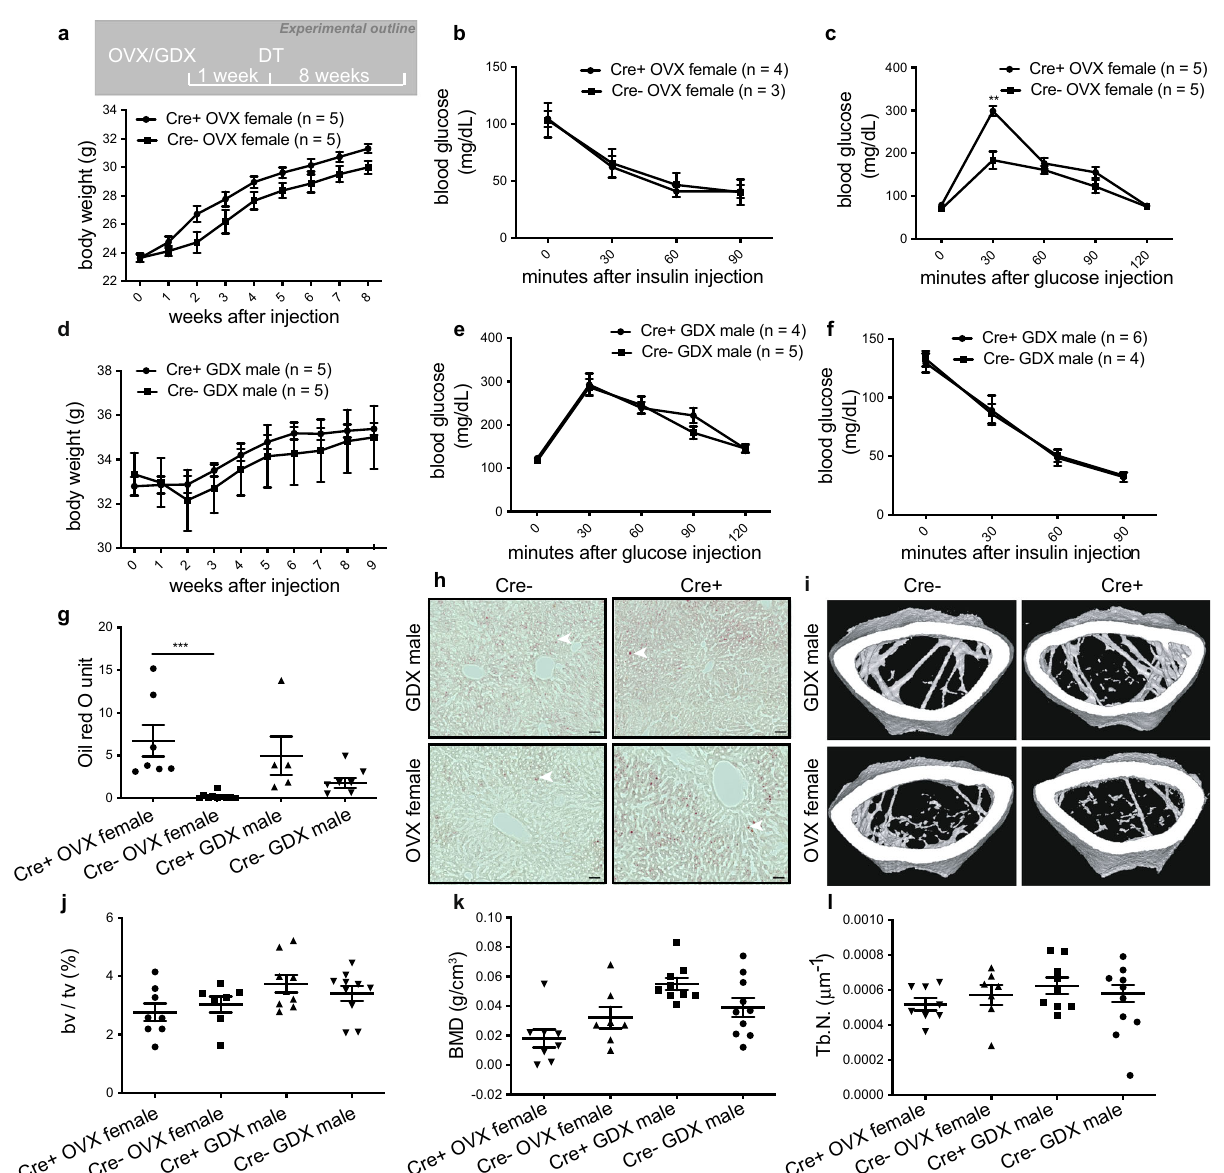
Fig. 1 | Acute gonadotrope ablation induces metabolic disorders in female mice. a Illustration depicting the strategy to acutely ablate gonadotropes via the injection of diphtheria toxin (DT) in mice selectively expressing the diphtheria toxin receptor in gonadotropes. b Number of GFP-positive cells within the pitui- taries of DT- or saline-injected GRIC/R26-iDTR/eR26- τ GFP mice and a number of follicle-stimulatinghormone(FSH)orluteinizinghormone(LH)positivecellswithin the pituitaries of DT-injected Cre+ and Cre − (control) GRIC/R26-iDTR/eR26- τ GFP mice. c Representative images of testes and female reproductive tracts from Cre+ and Cre − (control) GRIC/R26-iDTR/eR26- τ GFP mice 2 months after DT injection. Bodyweight( d , g ),glucosetolerance( e , h ),insulintolerance( f , i ),andliveroilredO staining quanti fi cation ( k ) from gonadotrope-ablated (Cre+) and control (Cre − ) female and malemice. j RepresentativeimagesofliveroilredOstainingfromCre+